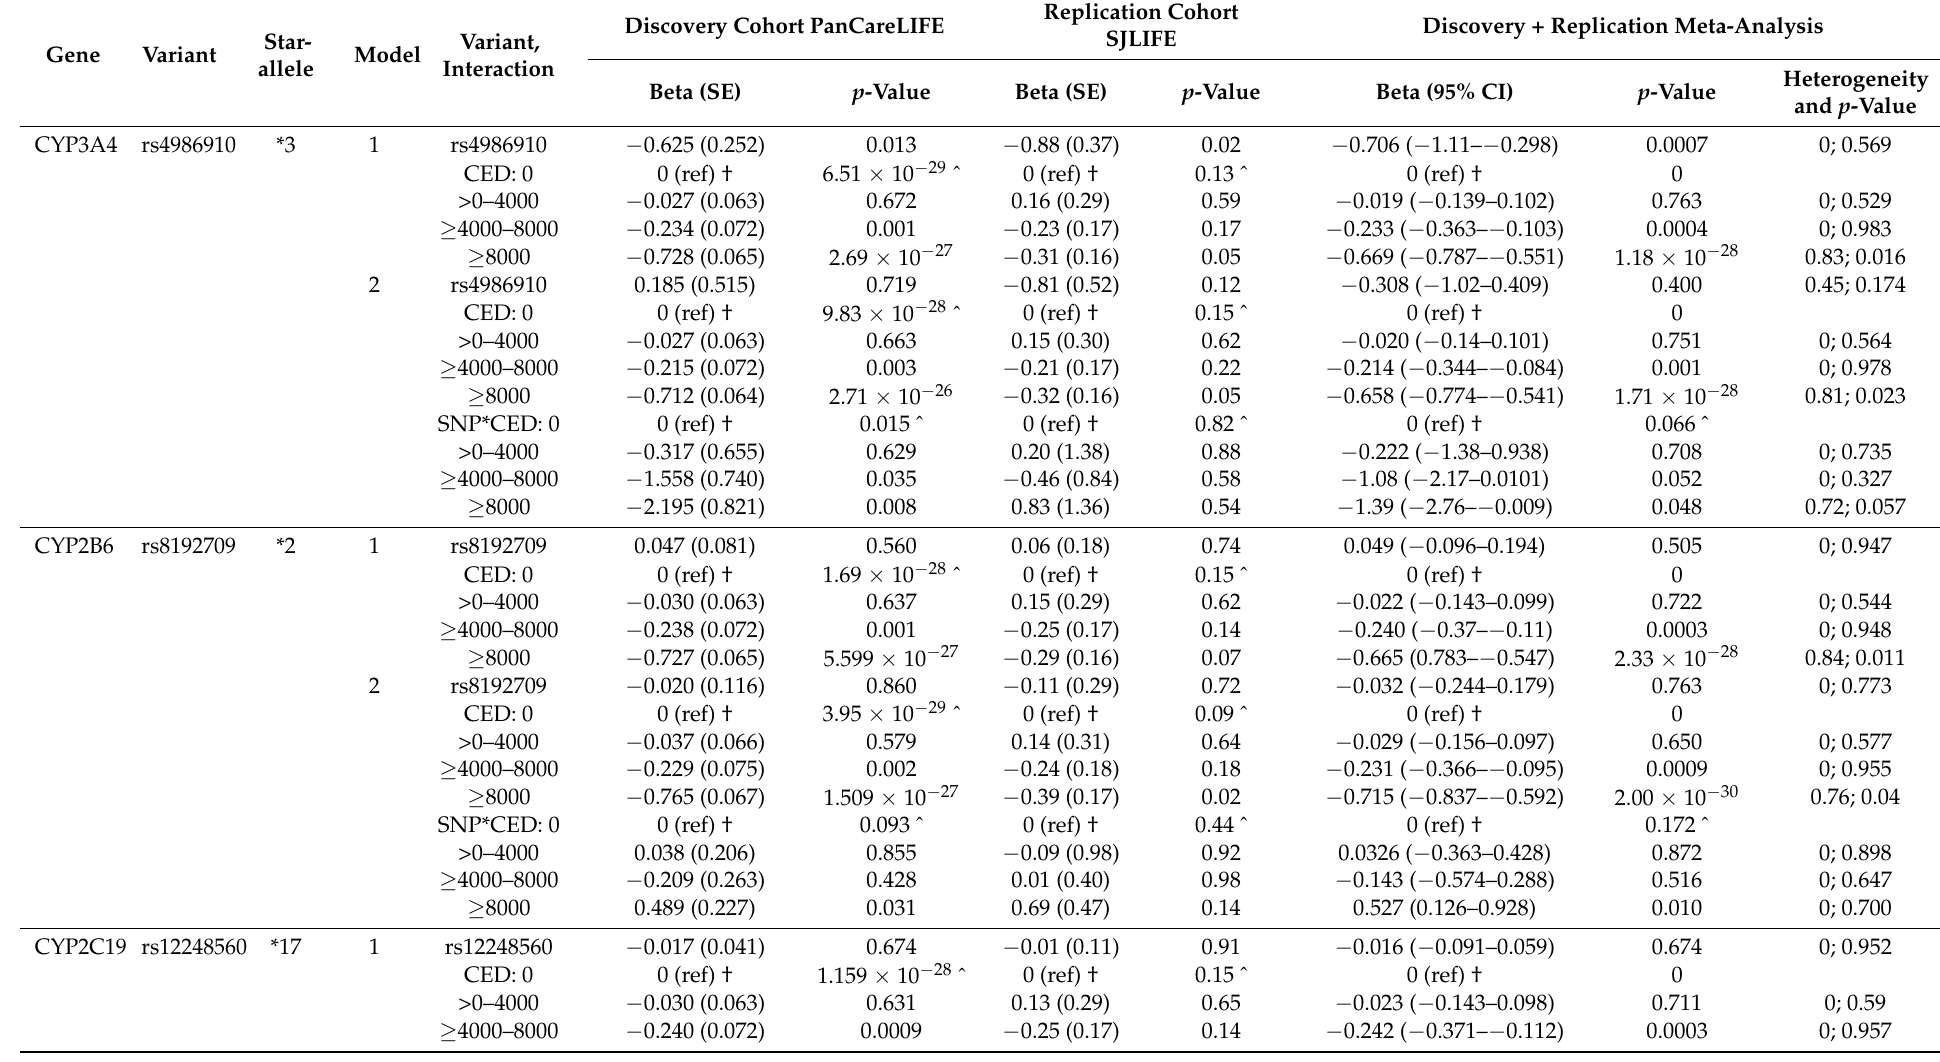
Table 3. Results of the linear regression based on log-transformed AMH and interaction of the Discovery cohort PanCareLIFE, Replication cohort SJLIFE, and meta-analysis.